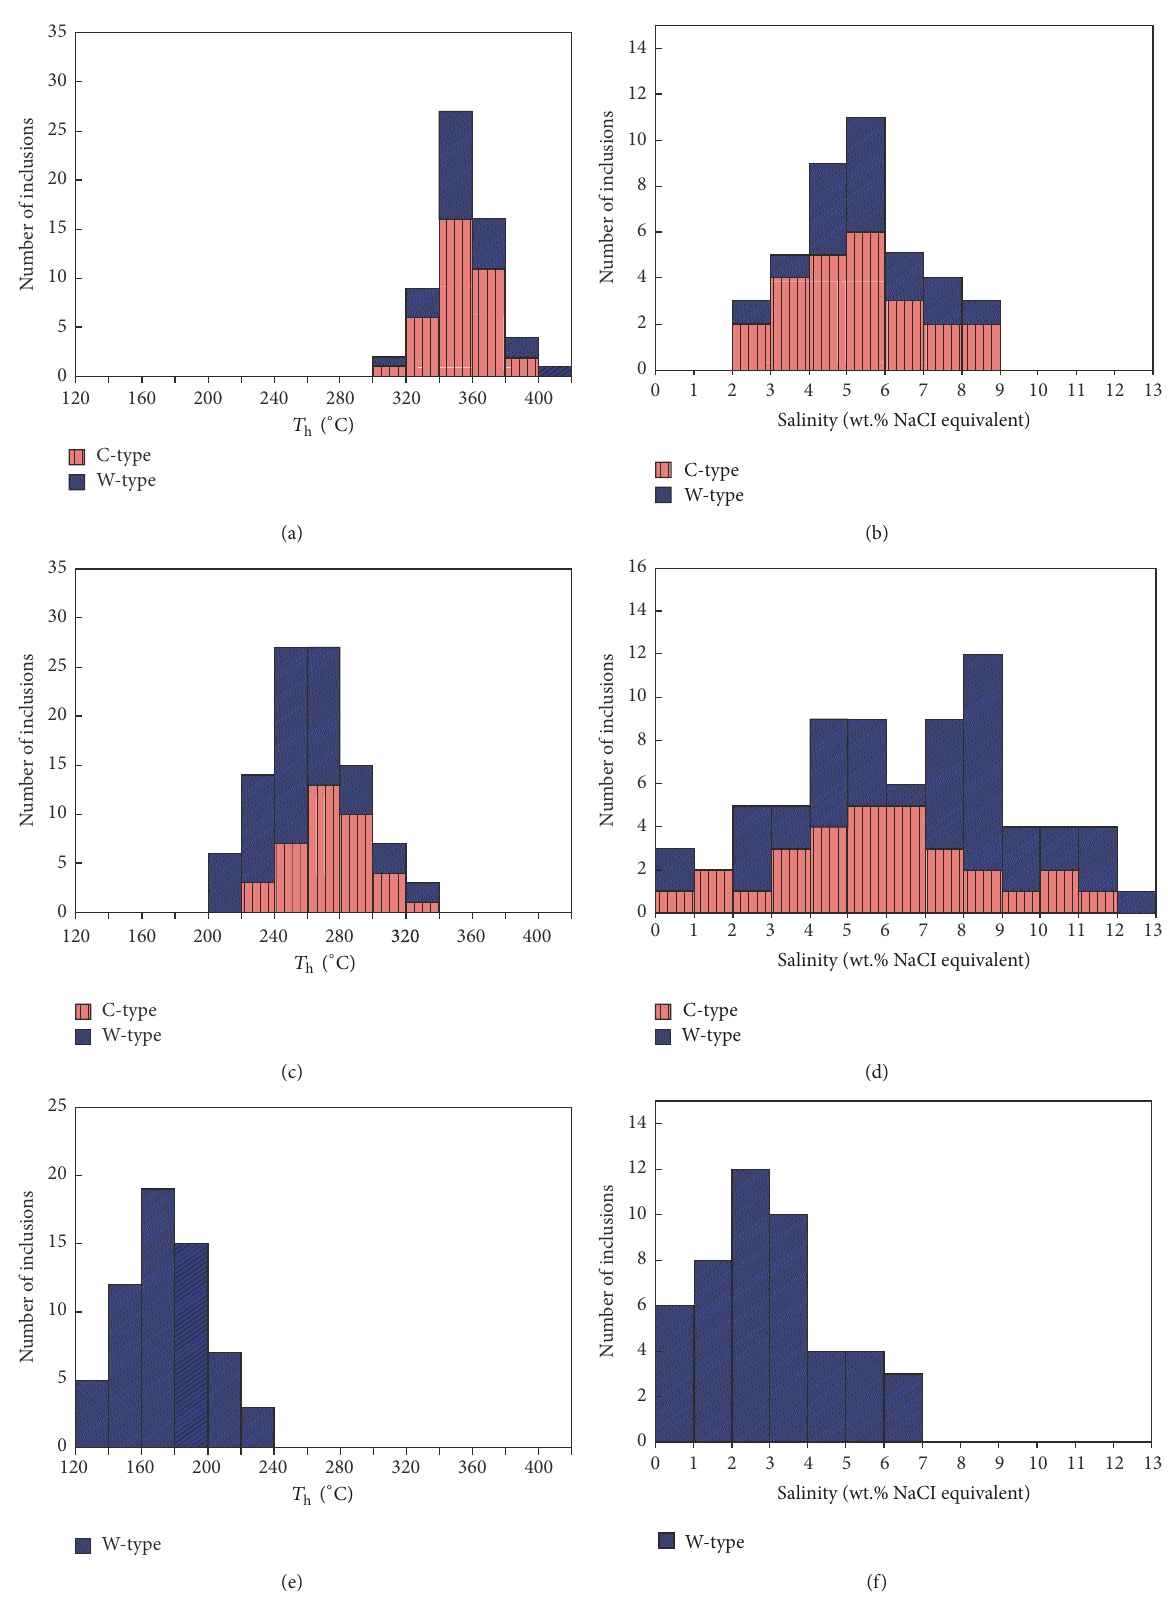
Figure 8: Histograms of total homogenization temperatures ( 𝑇 b), middle stage (c, d), and W-type fluid inclusions in the late stage (e,